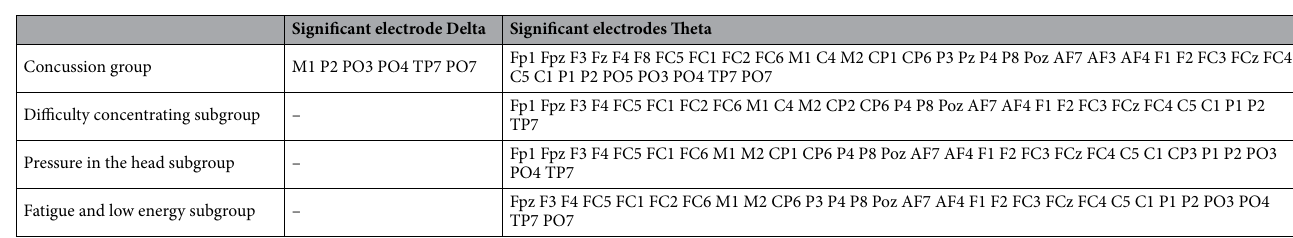
Figure 5. A topological plot of theta frequency band for three concussion symptoms subgroup. ( A ) Difficulty concentrating, ( B ) Pressure in the head, ( C ) Fatigue and low energy). It displays the difference of power spectral density, between POST and PRE, only for the statistically significant electrodes (0.008 ≤ p ≤ 0.049, represented by a blue star in the figure). Each subgroup presented significant electrodes on the frontal lobe (16 significant electrodes for difficulty concentrating, 15 for pressure in the head, and 14 for fatigue and low energy) for all of them, as well as an increase in the occipital lobe for the Pressure in the head (8 significant electrodes) and Fatigue and low energy (10 significant electrodes) subgroup.